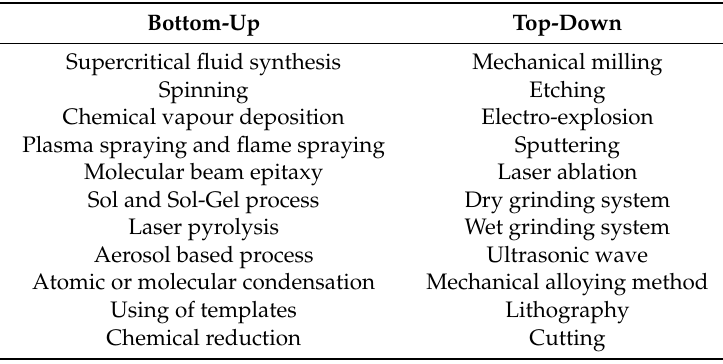
Table 4. Examples of bottom-up and top-down approaches